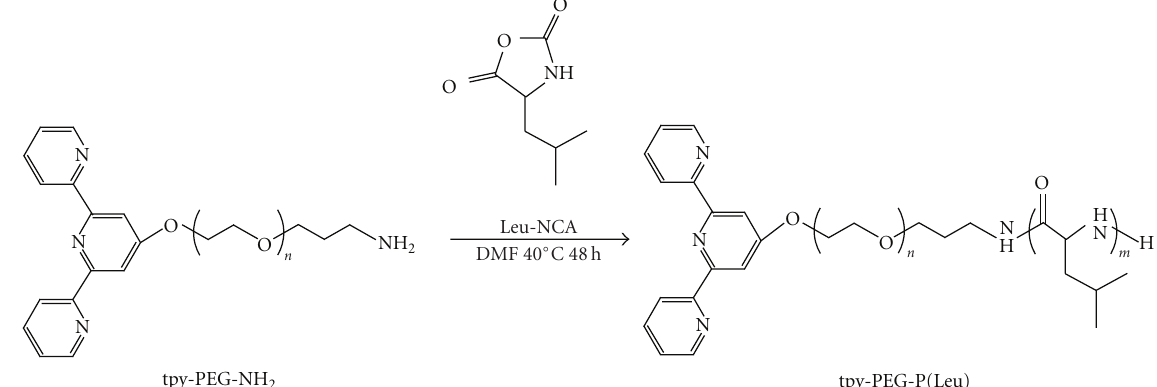
Scheme 2: Copolymerization of